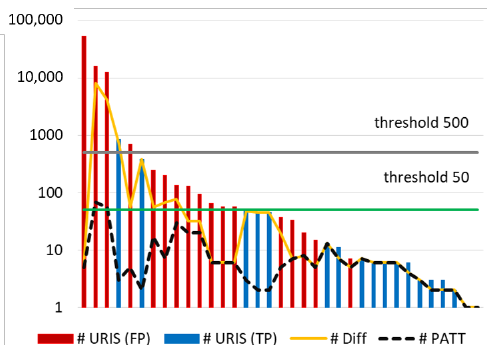
Figure 5. Statistics about the application of the methodology.